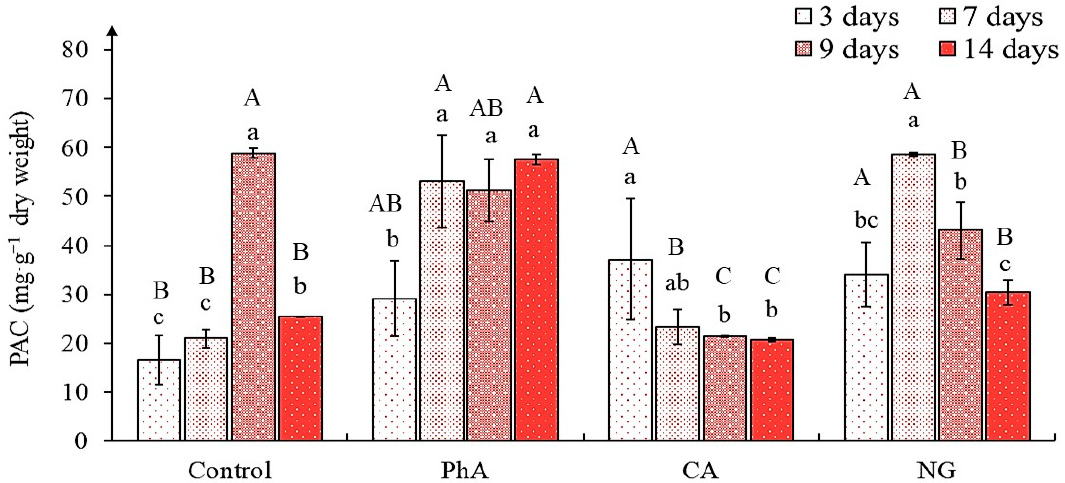
Figure 5. The proanthocyanidins content (PAC) in tea plant callus cultures of various ages grown on the liquid Heller culture medium of the basic composition (Control) or enriched with L -phenylalanine (PhA; 3 mM), trans -cinnamic acid (CA; 1 mM) or naringenin (NG; 0.5 mM). Results are expressed as means ± SDs, n = 3. The significant differences at p < 0.05 are denoted by different Latin letters: uppercase letters indicate significant differences between precursor treatments in alphabetic order from highest to lowest, lowercase letters indicate significant differences between duration of precursor treatments in alphabetic order from highest to lowest. Pairwise multiple comparisons were carried out using Tukey’s range test.